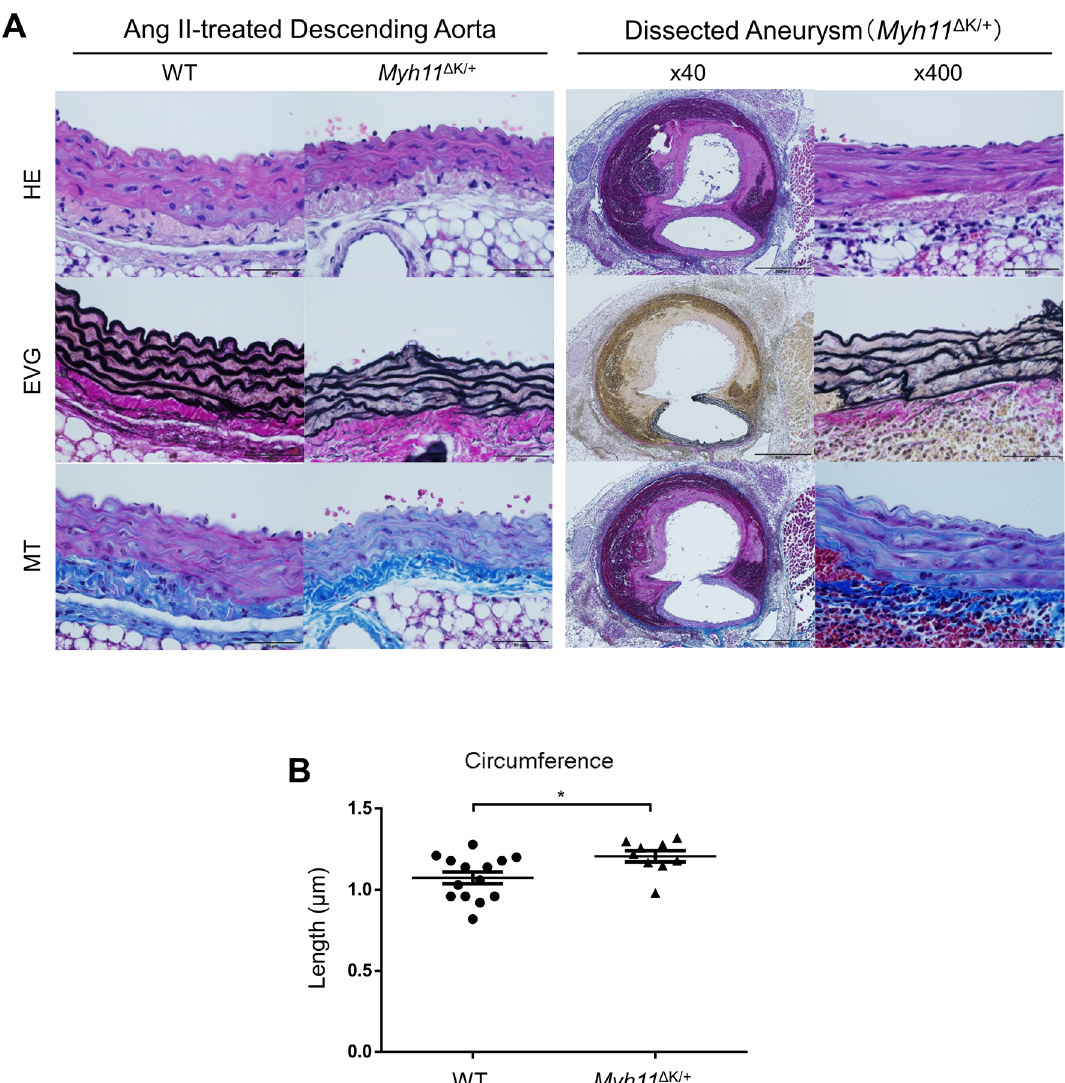
Figure 5. Angiotensin II (Ang II) infusion induces aortic dissection in MYH11 ∆K/+ mice. (A) Pathohistological images of descending aortas from Ang II-treated WT and Myh11 ∆K/+ mice. Cross-sections were stained with HE, EVG and MT (upper panel). The left part in the panel shows elastic fragmentation and fibrotic tissue deposition in non-dissected regions (scale bars = 50 µm, × 400). (B) Circumference of WT and Myh11 ∆K/+ ascending thoracic aortas after two weeks of Ang II infusion. WT: n = 14; Myh11 ∆K/+ : n = 9. * p < 0.05, Mann–Whitney U